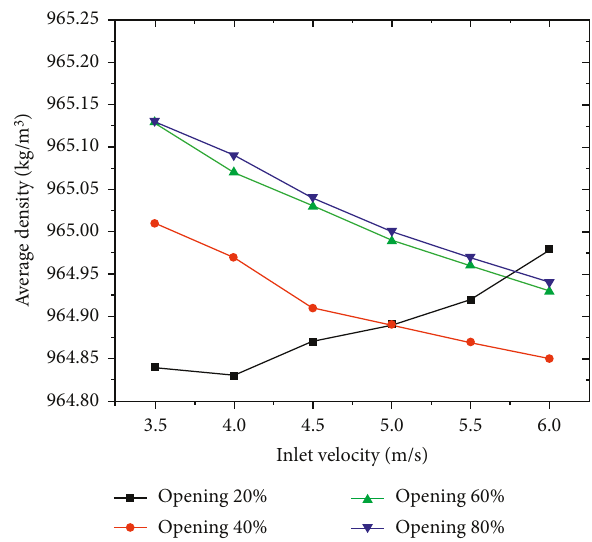
Figure 42: Variation of inlet velocity and average density with openness at constant temperature.